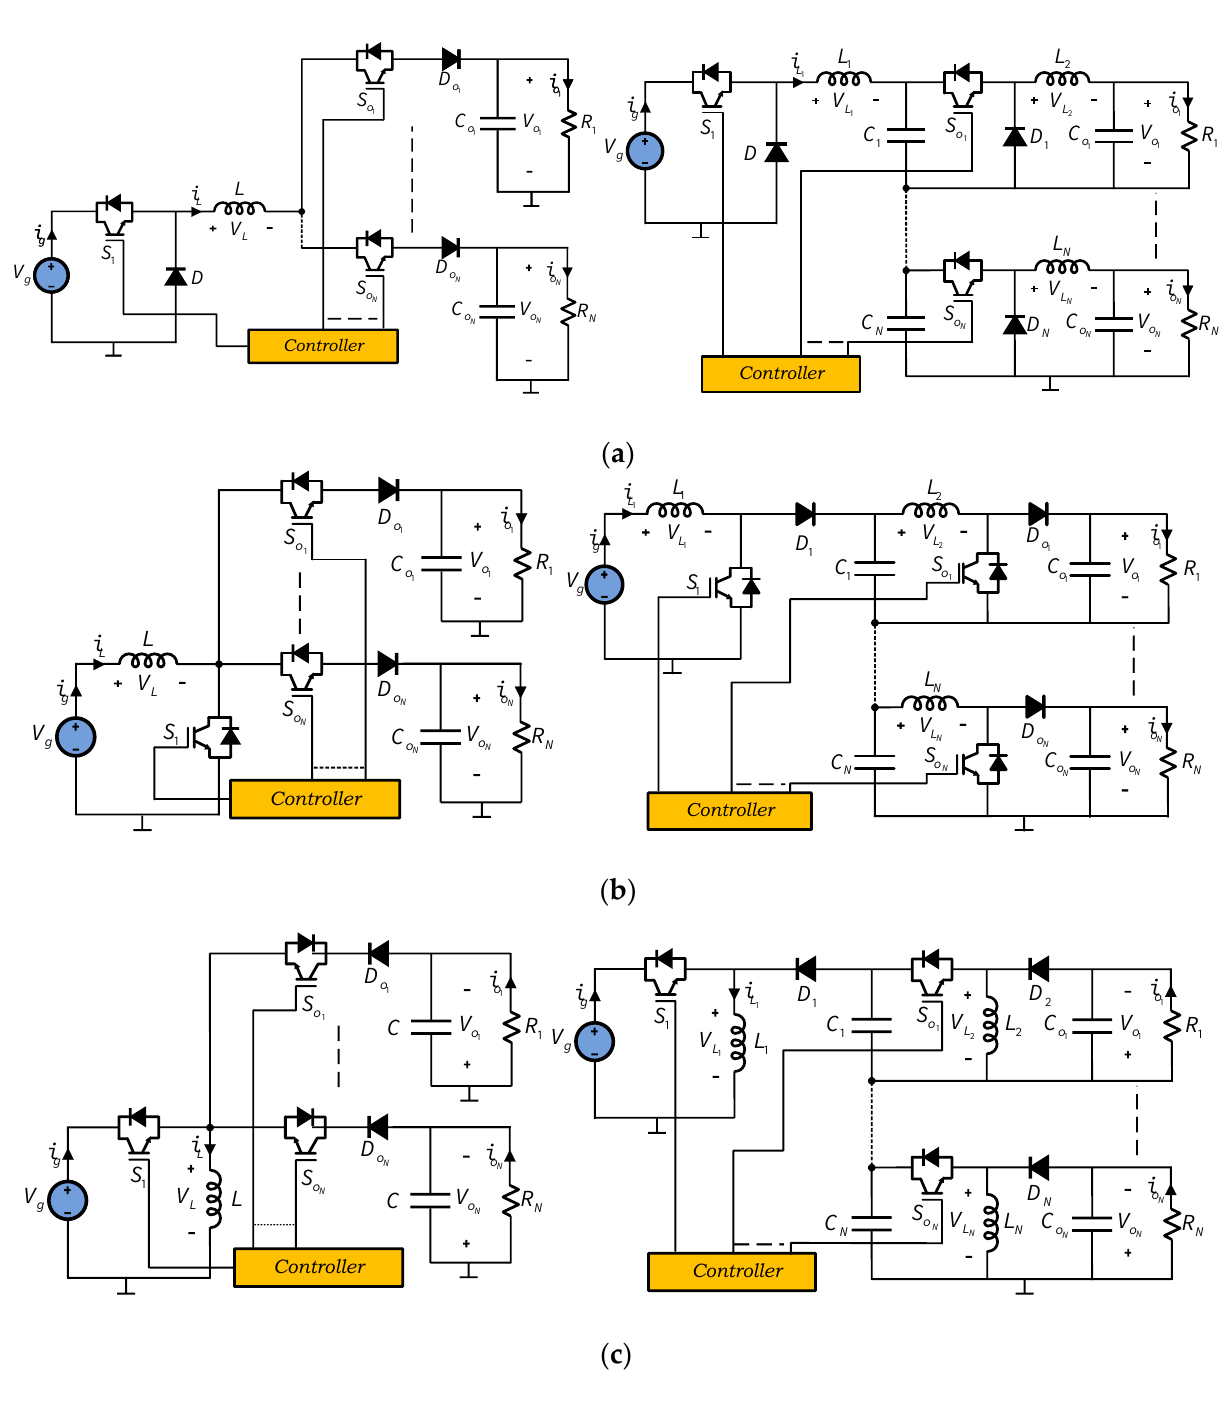
Figure 7. Single Input Multiple-Output (SIMO) non-isolated multiple switches DC–DC converters. ( a ) SIMO Buck Converter versions [57]. ( b ) SIMO Boost Converter versions. ( c ) SIMO Buck–Boost Converter versions.